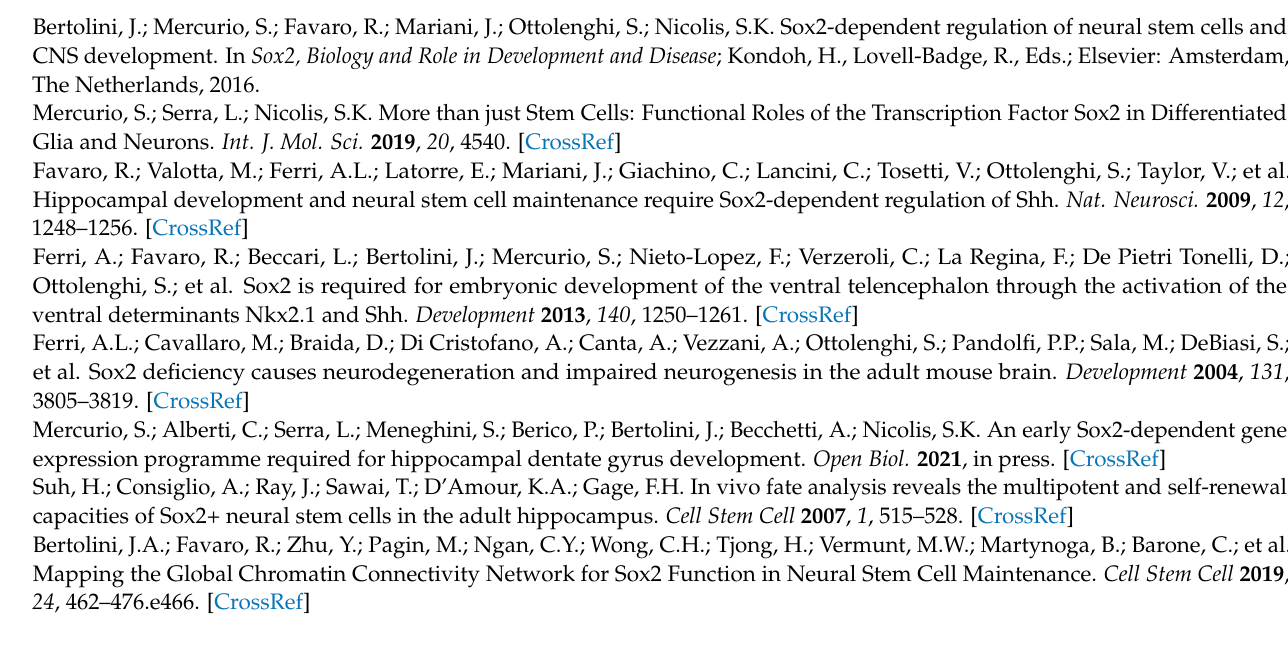
interaction network from Figure 6, showing the biggest network using MCL 1.1, Table S1: RNA-Seq Expression Data for WT and Sox2-del NSC at D4 and D11, Table S2: Lists of genes belonging to each GO term in Figure S2 are given (sheet: enriched gene set GO analysis), Table S3. GREAT annotation of subnucleosomally enriched peaks shared between SOX2 and AP1 (.xcl file), Table S4. DAVID Gene Ontology analysis of genes bound by SOX2 and AP1 that are expressed in NSC (.xcl file), Table S5. Genes bound by SOX2 and AP1 and downregulated in SOX2-deleted NSC (.xcl file), Table S6. STRING Gene Ontologies for genes bound by SOX2 and AP1 and downregulated in SOX2-deleted NSC (.xcl